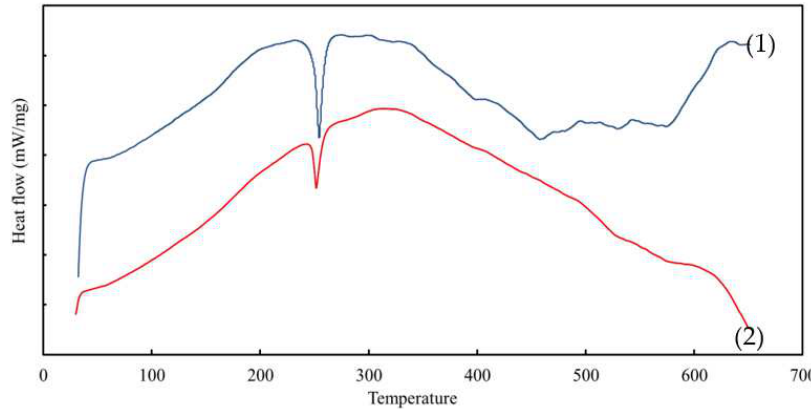
Figure 5. The DSC curves of the (1) PIM and (2) nanoparticle-incorporated MM-PIM. The T g values of the MM-PIM samples were nearly 9.5 °C greater than those of the PIM samples. The increment in the MM-PIM glass point revealed an improvement in the thermal stability of the membrane due to the presence of covalent bonding between the carbon nanotubes with the membrane polymer chains. The covalent bonds subsided the free volume and motility of the polymer chains, increasing the T g values of the membranes [59,60]. The MM-PIMs demonstrated another apparent curve at the cold crystallisation tem- perature of 252.16 °C, exhibiting a smaller exothermic peak than the PIMs. The observa- tion denoted that the carbon nanotubes induced a faster solidification rate of the MM- PIMs to the crystallisation phase. Furthermore, at 573.49 °C, a decomposition phase was observed on the PIM thermogram, whereas a minor endothermic peak was observed at a similar point in the MM-PIMs. The findings implied that the carbon nanotubes could pre- vent membrane mass degradation. Accordingly, the results affirmed that the incorpora- tion of carbon nanotubes in PIMs could promote thermal stability and intermolecular in- teraction between the nanomaterials and different constituents in the membrane [61]. 3.5. The IEC Study Figure 6 illustrates the IEC values of the W1, W2, W3, W4, and W5 samples. The data reveal that higher concentrations of nanomaterials lowered the IEC of the membrane from 0.819 to 0.592 mEq/L. The observation might be ascribed to the reduced access of potential of ion exchange groups into the membrane matrix due to increased particles invading the area surrounding the resin particles [53]. Furthermore, the larger inclusion concentration of nanomaterials in the doped solution caused more functional groups in the membrane matrix to be enclosed and detached by the CNT particles. Consequently, the accessibility of ion exchange was limited, which significantly affected the ion conductivity of the PIMs [52].